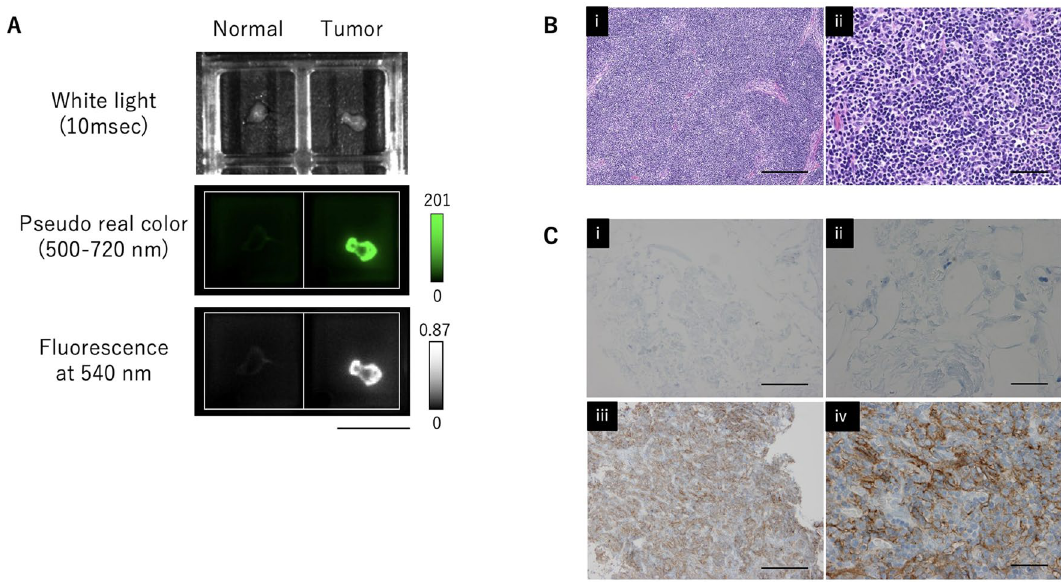
Figure 4. Histological and immunohistochemical staining of GGT in tumor samples. ( A ) Ex vivo fluorescence imaging of pieces of normal and tumor tissue a few millimeters in size after 30 min incubation with 50 μM gGlu-HMRG. Scale bar, 10 mm. ( B ) Histology of thymoma (HE). (i) Scale bar, 250 μm. (ii) Scale bar, 50 μm. ( C ) GGT IHC. Negative in fat tissue (i, ii). High GGT expression in thymoma (iii, iv). (i, iii) Scale bar, 250 μm. (ii, iv) Scale bar, 50 μm.